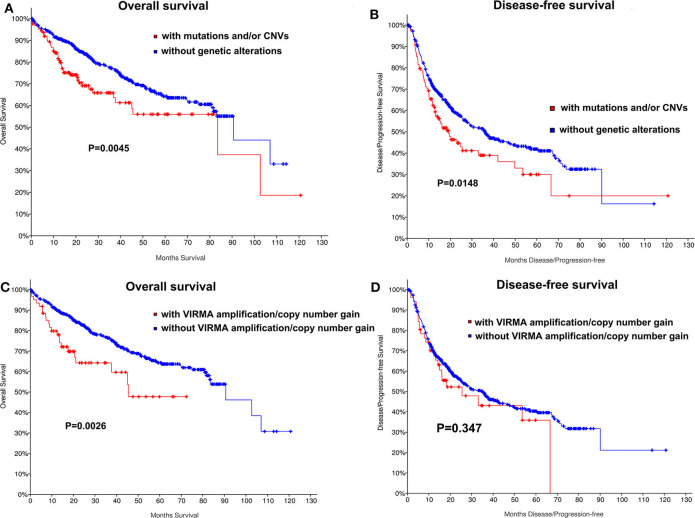
Genetic alterations of m6A regulatory genes in HCC. (A) Percentage of HCC samples with mutations or CNVs of the m6A regulators based on the data from TCGA. (B) Events of copy number gain or loss of m6A regulatory genes in HCC samples. (C) Relationships between Putative copy-number alterations and mRNA for FTO. (D) Relationships between Putative copy-number alterations and mRNA for ALKBH5.